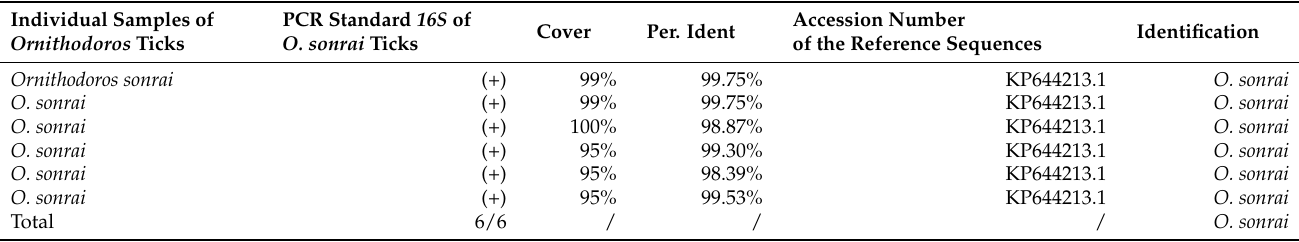
Table 1. Blast analysis results for molecular identification of Ornithodoros sonrai ticks collected in Dodel,